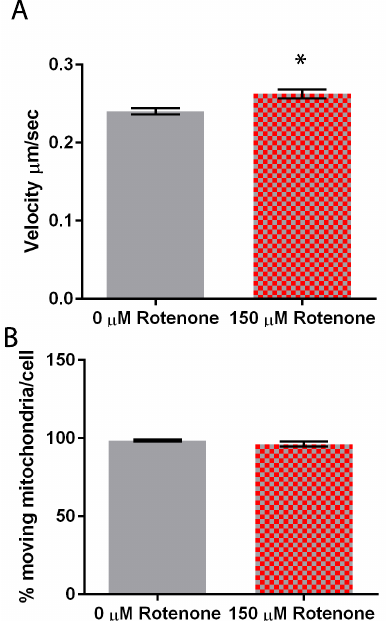
Figure 3. Mitochondrial motility in DMSO and rotenone treated cells. ( A ) Rotenone significantly increased velocity by 9.3% when compared to DMSO treated cells ( p = 0.0016), ( B ) while the percent of moving mitochondria was unaffected. Sample size is n = 50 with standard error being represented by error bars on each column. * indicates significant difference between